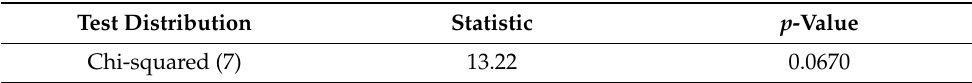
Table 8. Hausman test.